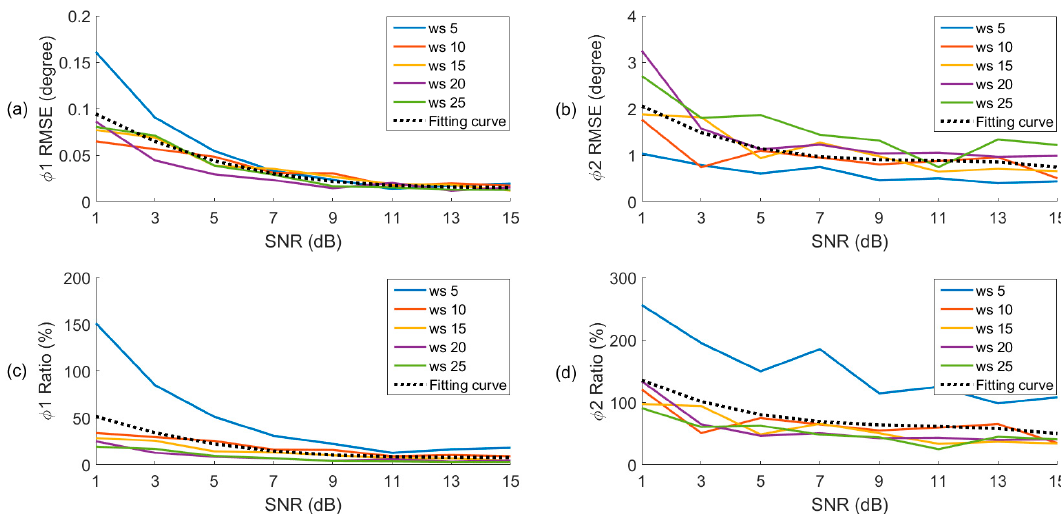
Figure 12. Root-mean-square error (RMSE) of angles ( a ) ϕ 1 and ( b ) ϕ 2 derived from DDMs with different SNRs and wind speeds. The ratio of RMSE to the corresponding amplitude of the oscillation of angles ( c ) ϕ 1 and ( d ) ϕ 2